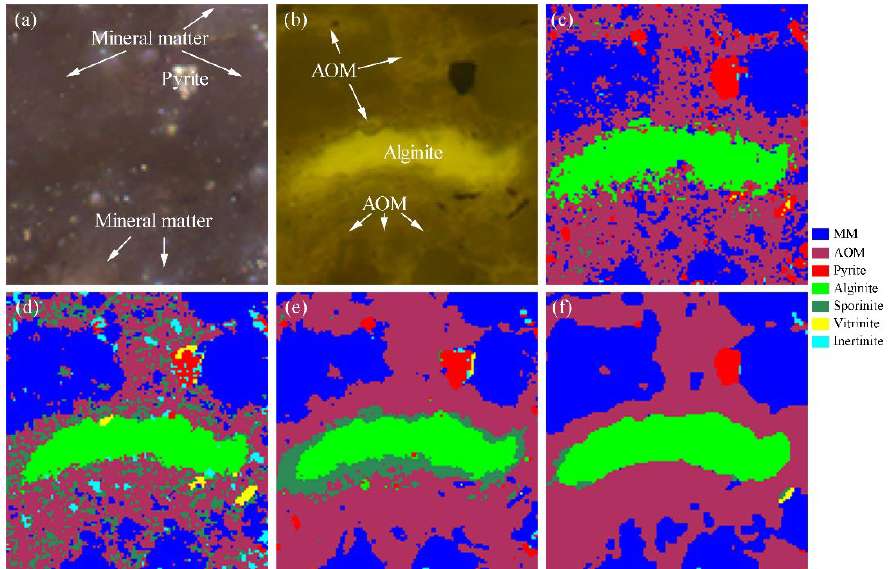
Figure 5. Examples of the results of different classification methods in the software. ( a ) reflected-light photomicrograph; ( b ) fluorescent-light photomicrograph, same field as ( a ); ( c ) maximum likelihood classification results; ( d ) Mahalanobis distance classification results; ( e ) neural net classification results; ( f ) SVM classification results. MM: Mineral matter.